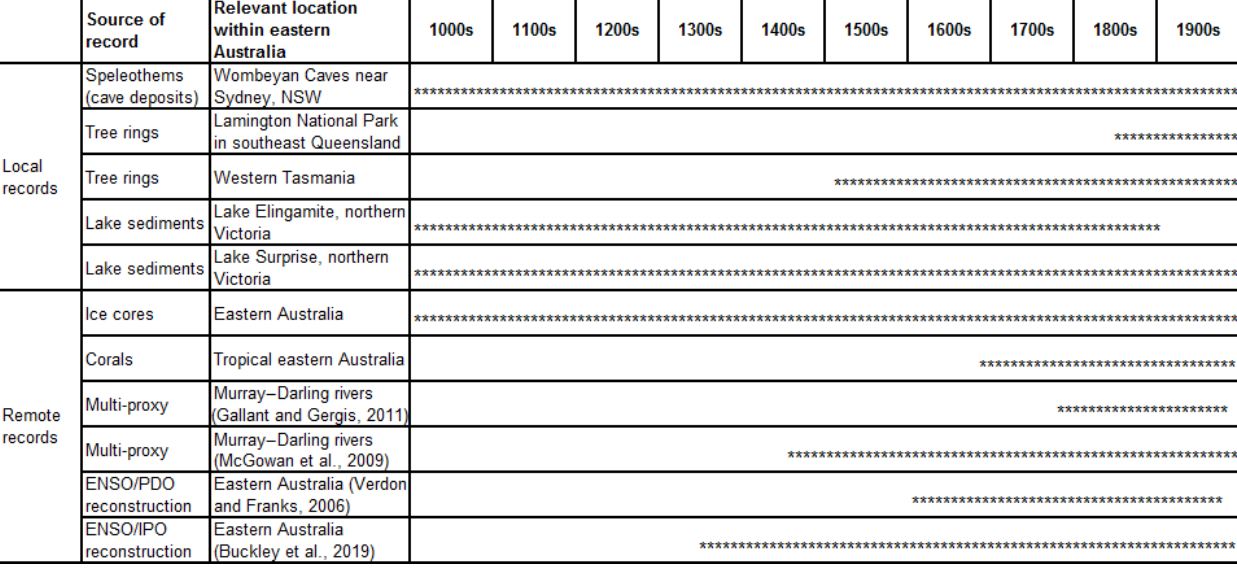
Figure 2. Time period covered by the published palaeoclimate records used in this